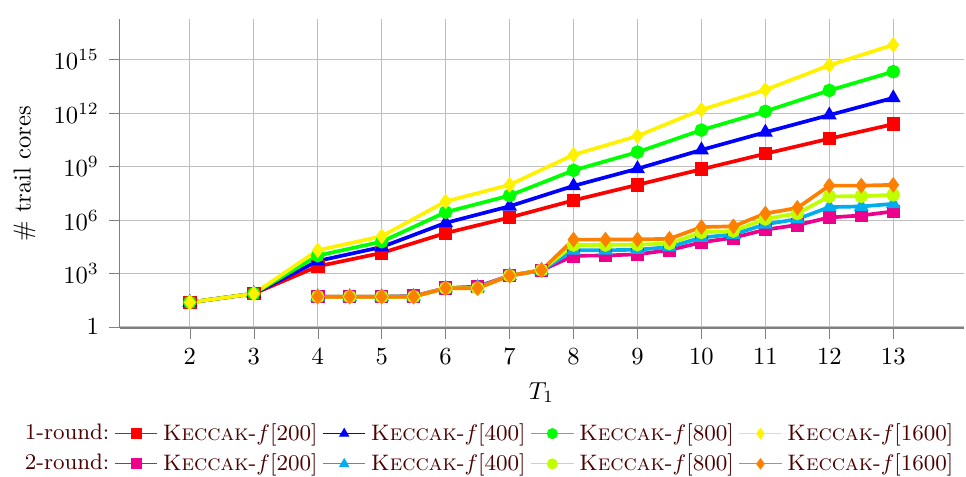
Figure 1: Number of 1-round and 2-round trail cores in Keccak - f modulo z -symmetry with weight T 1 per